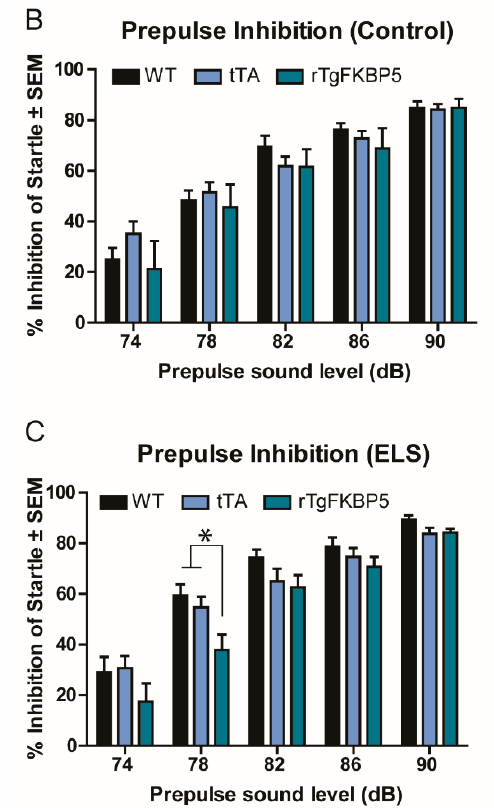
Figure 2. Interaction of FKBP5 and early life stress does not a ff ect startle response. ( A ) Baseline startle response. Percentage of prepulse inhibition to 74, 78, 82, 86, and 90 dB acoustic stimulus compared to the baseline startle for the ( B ) control and ( C ) ELS groups. Data are represented as standard error of the mean (SEM) and analyzed by repeated measures two-way ANOVA (see Table 1 for analysis). * = p < 0.05 when comparing ELS-genotype di ff erences. ELS = early life